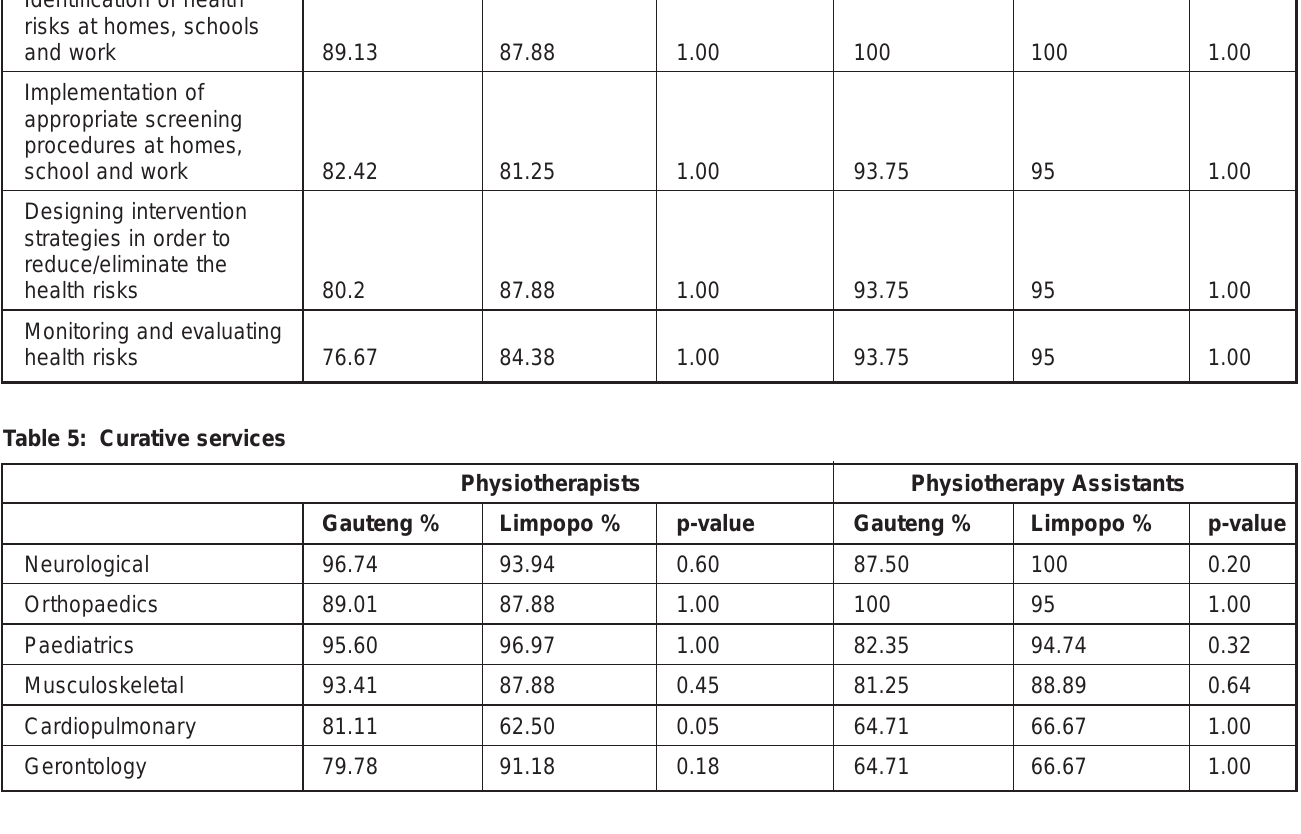
Table 6: Detailed Curative